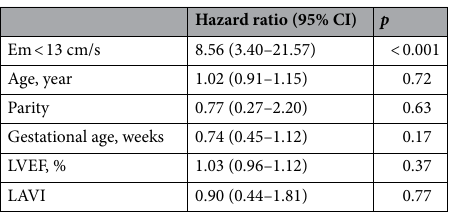
Table 5. Cox proportional hazard model-multivariable analysis. 95% CI 95% confidence interval, LVEF left ventricular ejection fraction, LAVI left atrium volume